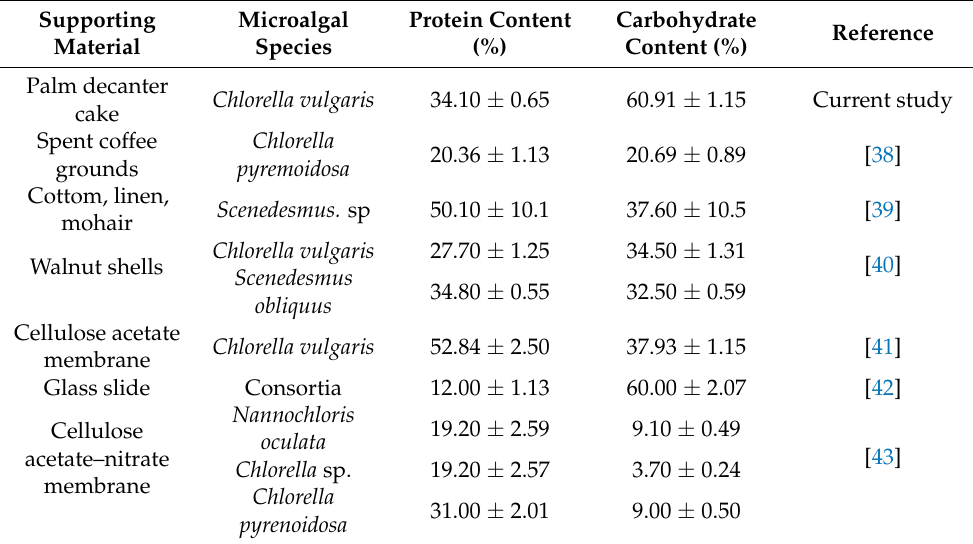
Table 3. Protein and carbohydrate accumulation derived from attached microalgal biomasses growing on various supporting